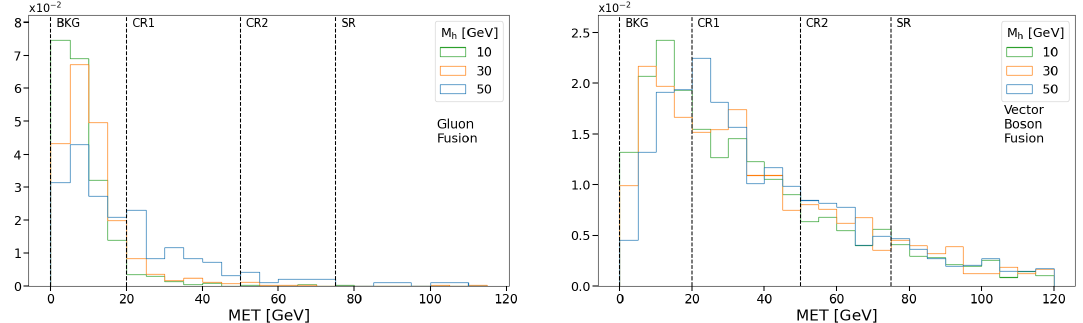
Figure 6 . Missing energy distribution of heavy neutrino decays, for several M h . Higgs production via gluon fusion (vector boson fusion) is shown on the left